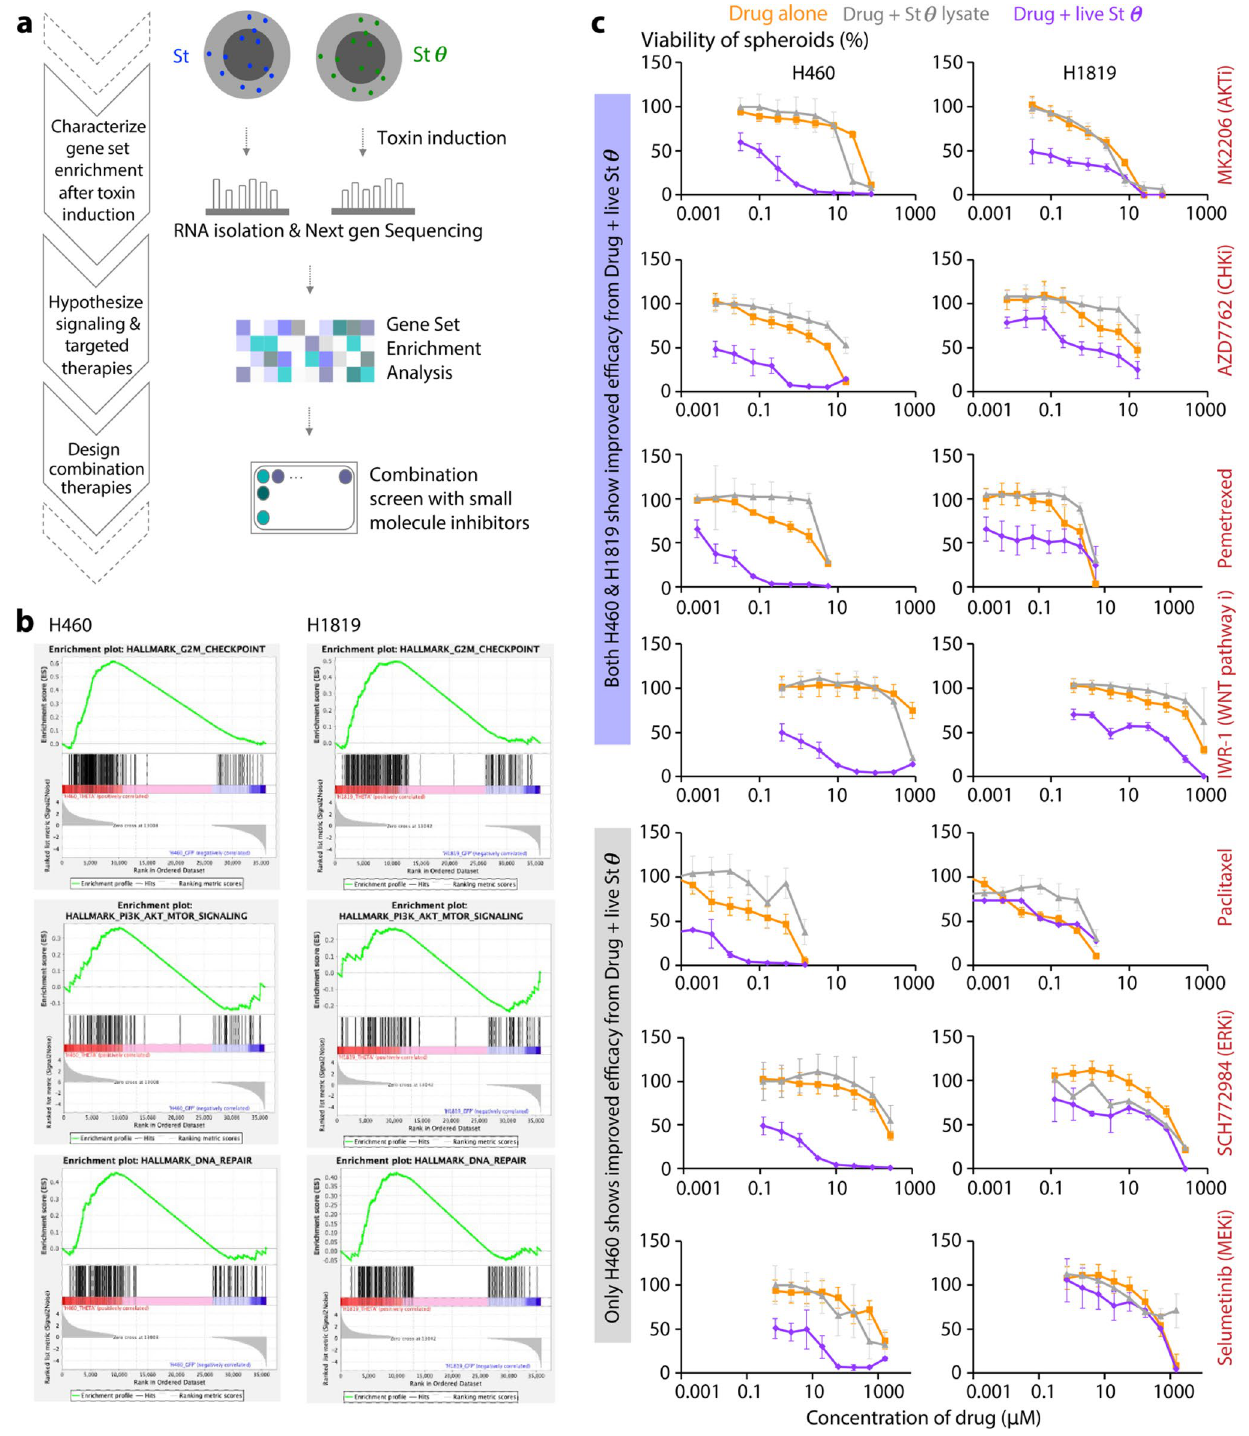
Figure 3. Characterizing NSCLC’s response to bacterial therapeutics and designing combination therapies. ( a ) Schematic of the third part of the pipeline to characterize the NSCLC’s response to S. typhimurium -secreted theta toxin, using RNA sequencing, bioinformatic analysis, designing and testing combination treatment regime in vitro. ( b ) Gene Set Enrichment Analysis (GSEA) plots (representatives of 3 gene sets) from analyzing Next Gen RNA-sequencing data of 2 NSCLC spheroids, H460 and H1819 co-cultured with live S. typhimurium expressing θ toxin (Stθ) and GFP compared to spheroids with live Salmonella producing only GFP (n = 3). ( c ) Viability of 2 NSCLC spheroids, H460 and H1819, treated with 7 small molecule inhibitors (MK2206, AZD7762, Pemetrexed, IWR-1, Paclitaxel, SCH772984 and Selumetinib, targeting specific signaling identified by GSEA, under 3 treatment conditions: (1) Drug alone, (2) Drug and bacterially secreted θ (Stθ) in co-culture, (3) Drug and lysates of S. typhimurium producing θ toxin (n = 3, error bars represent standard deviation). Drug concentrations are in μM